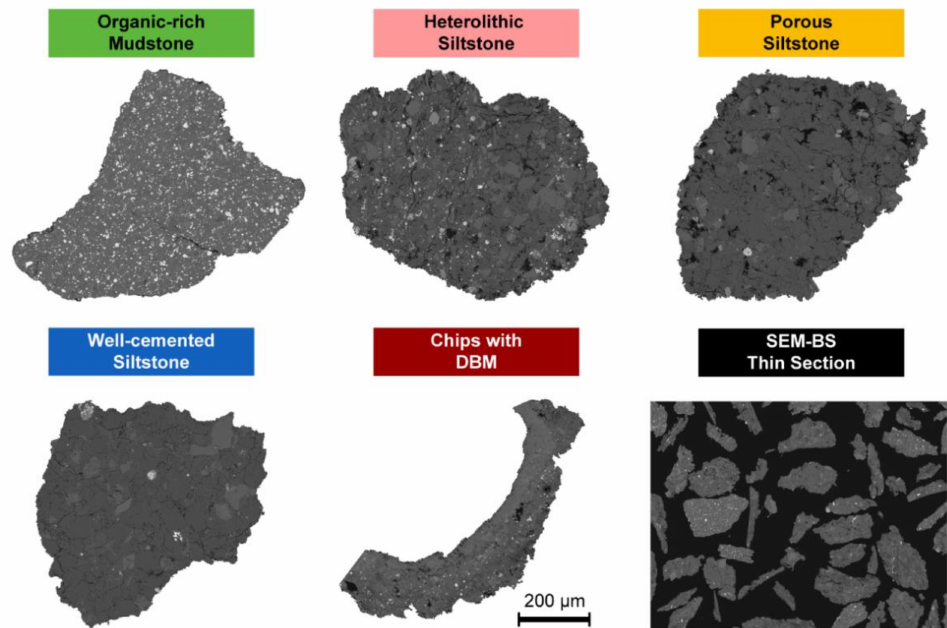
Figure 8. SEM-BS images showing examples of the five rock types classified based on textural characteristics. The lower right picture displays a portion of a thin section imaged through SEM. Each thin section contained approximately 1000 rock chips.